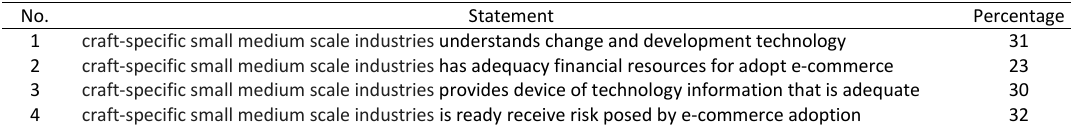
Table 3: Assessment variable organization readiness